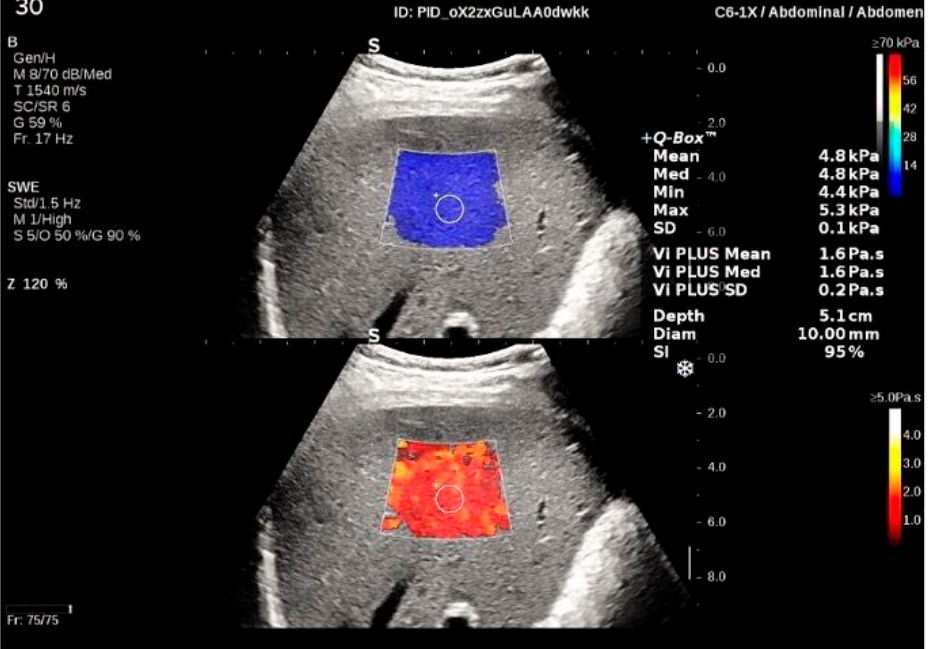
Figure 1. Illustration of a two-dimensional shear-wave elastography (2D-SWE) and a viscosity (Vi PLUS) measurement made in a healthy subject. Two-color scale maps are shown. In the upper half of the image, the 2D SWE map is displayed. Low stiffness is color-coded with blue, while red signifies high stiffness. The viscosity map is illustrated in the lower part of the image. Colors close to red indicate low viscosity, while yellow–white represents high viscosity. Quantitative results of 2D-SWE (expressed in kPa) and Vi PLUS (expressed in Pa·s) are displayed in the right part of the image. The mean, median, minimum, maximum, and standard deviation (SD) of the measurements, along with the depth, the diameter of the region of interest (ROI), and the Stability Index (SI) are also presented.